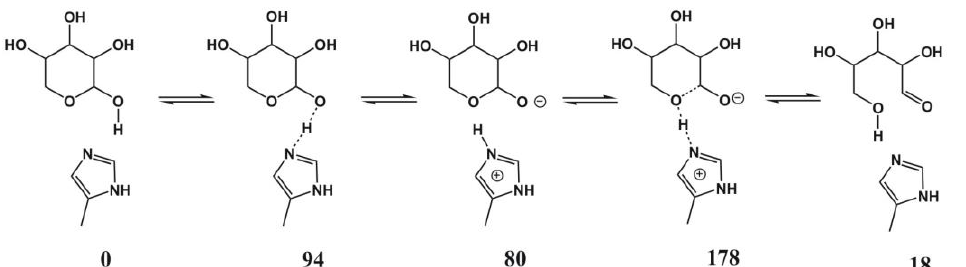
Figure 20. Initial, transition and final structures in the proton transfer steps of the ring opening reaction (relative energies are given in